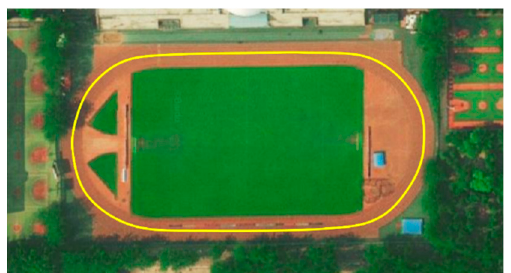
Figure 9. Presupposed trajectory in the practical experiment.